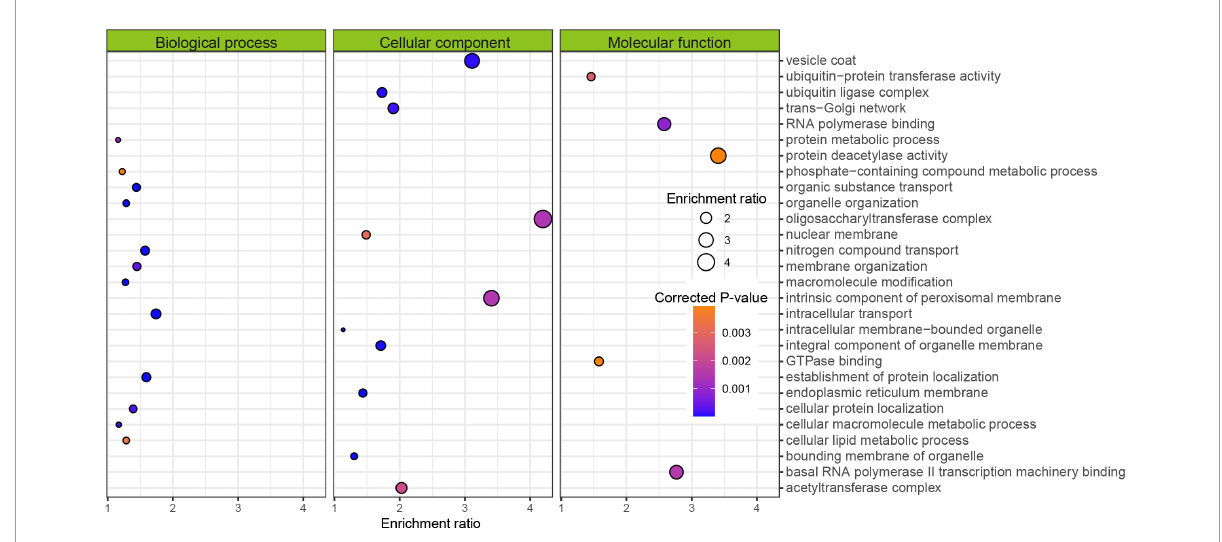
FIGURE2 Gene Ontology (GO) enrichment of genes within the blue module from Figure 1 . Enrichment ratio means the concentration of GO terms in the target group compared to those in the population.